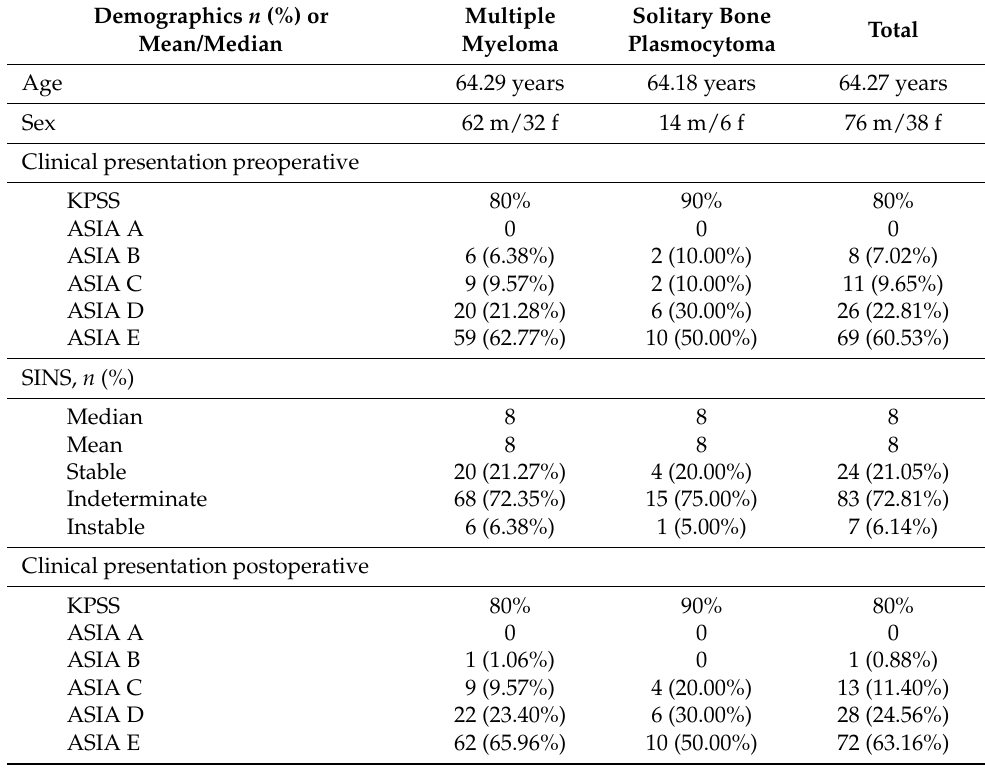
Table 1. Demographic and clinical data